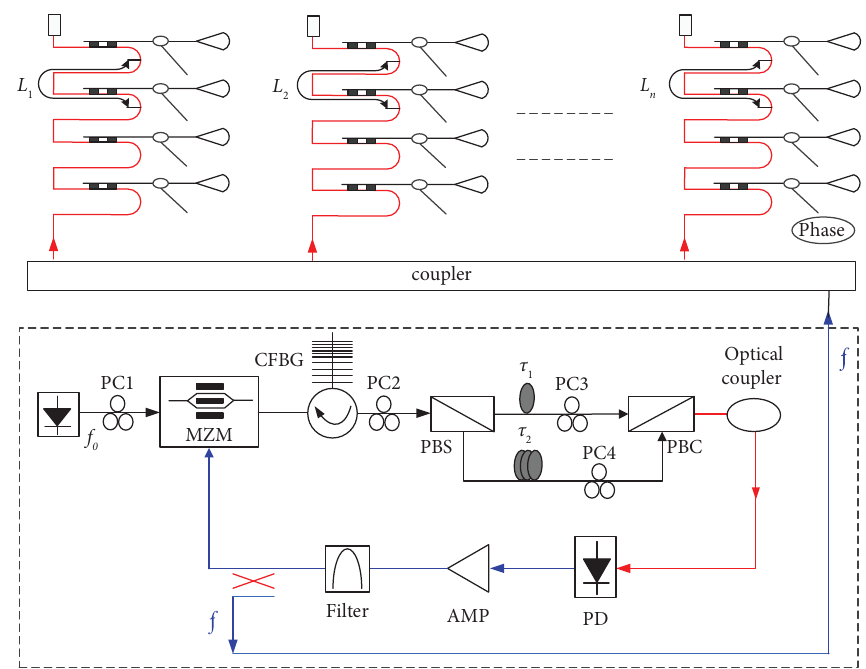
Figure 10: Two-plane multibeamforming system composition diagram.